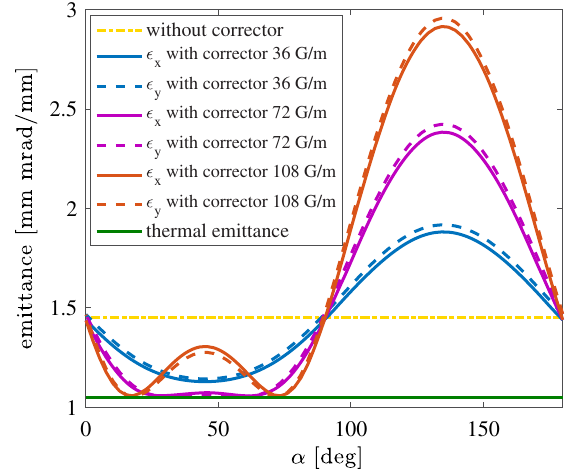
FIG. 13. Simulated emittance correction by scanning the strength and rotation angle α of the quadrupole corrector. The emittance is normalized by the laser spot